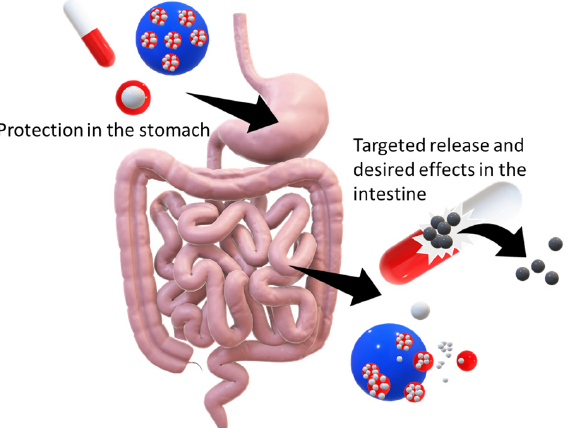
Figure 3. Schematic representation of the behaviour of several systems (capsules, particles and multiple emulsions) with encapsulated compounds in the gastrointestinal tract.